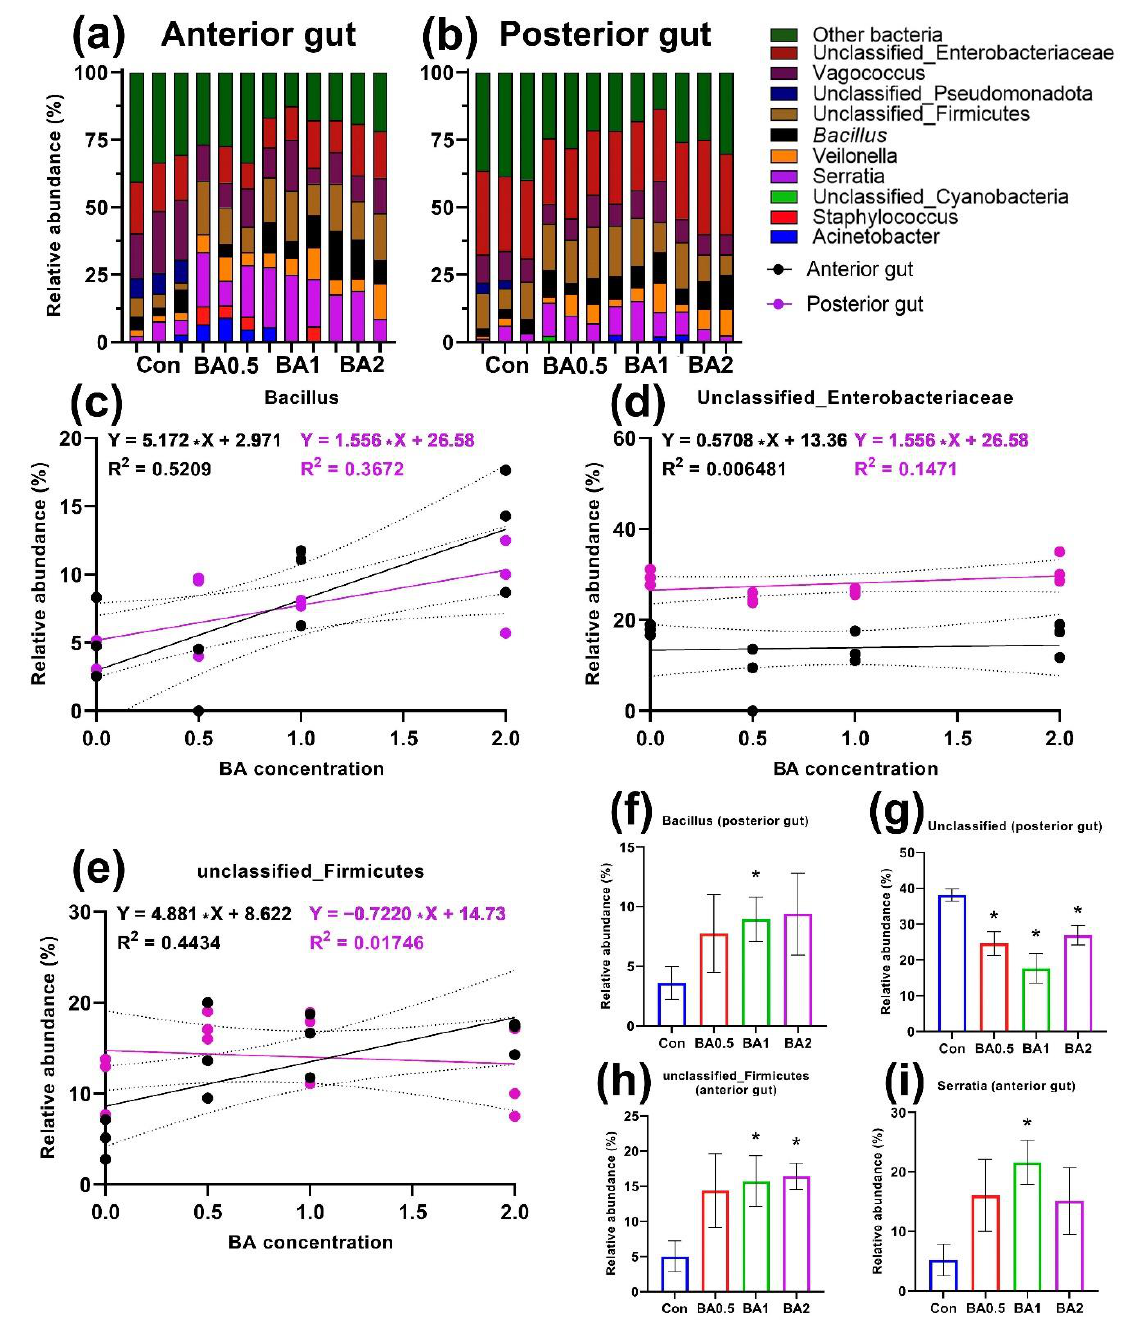
Figure 2. Cultivated microbiota of the anterior and posterior sections of the intestine of the experimental groups of D. rerio receiving butyric acid ( n = 3). Unclassified bacterial groups are labeled within defined taxonomic groups. Unclassified bacterial groups are labeled within defined taxonomic groups: ( a , b ) relative abundance of microbiota by bacterial genus in the anterior and posterior gut sections, respectively; ( c – e ) linear regression of the relative abundance of Bacillus , unclassified_ Enterobacteriaceae and unclassified_Firmicutes groups and BA concentration in the anterior (black points) and posterior (purple points) sections; ( f – i ) relative abundance of different bacteria groups in the control and experimental groups. The p -value (*— p < 0.05) from the Mann-Whitney test.